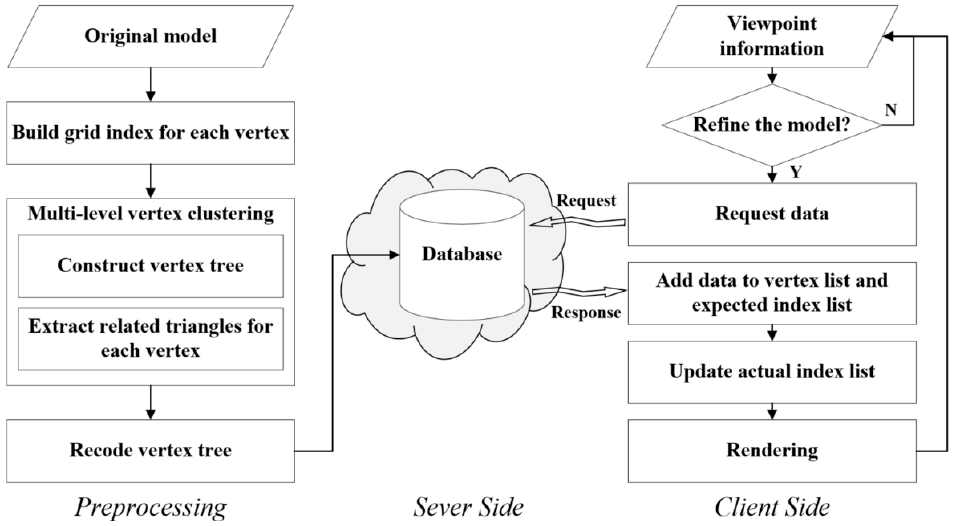
Figure 4. Overall flow chart of our